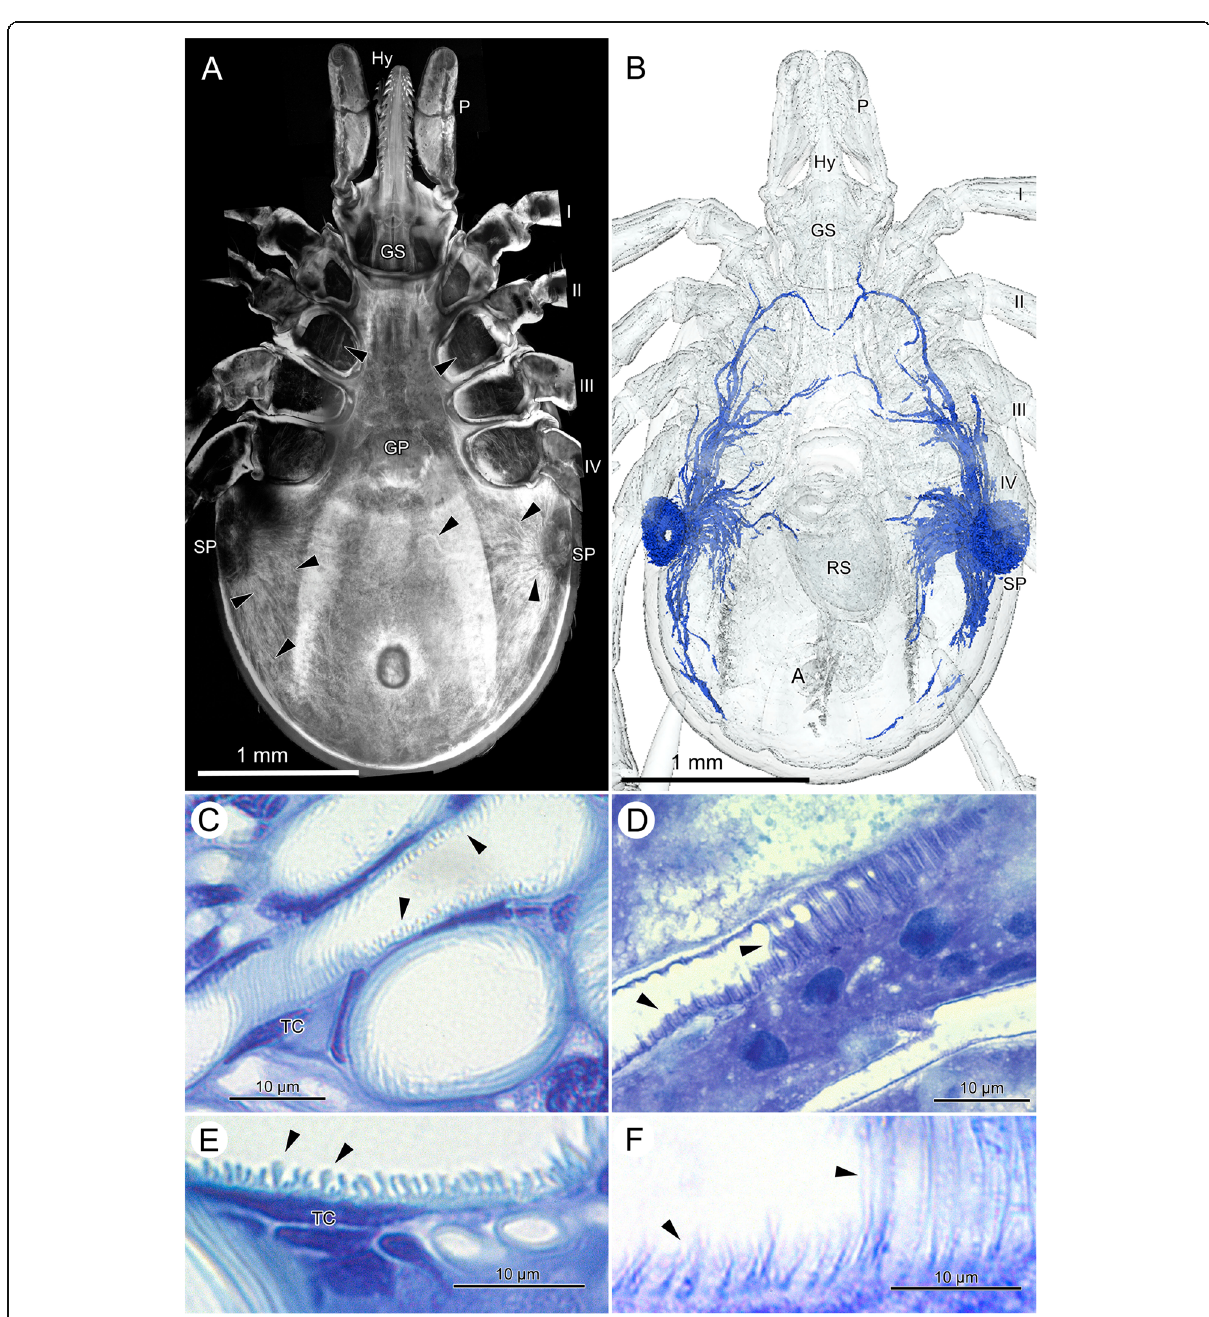
Fig. 6 Ixodes ricinus, cross morphology and histology of the tracheal system. a Autofluorescent CLSM image of the tracheal system, macerated specimen; ventral view; arrowheads indicate tracheae. b 3D-reconstruction of the major tracheal trunks based on μ CT-image stacks; ventral view. Tracheae are modeled in blue. The spatial resolution of the μ CT-images is about 15 μ m to recognize individual tracheae, therefore only tracheae larger than 15 μ m are shown. c LM micrograph with longitudinal and cross-sectional sections of tracheae from a fasting animal; arrow-heads indicate taenidia. d LM micrograph with longitudinal sections of tracheae from a fully engorged animal. Note that the taenidia are almost completely flattened as compared to ( c ); the un-stretchable core of exocuticle in the taenidia can be recognized as a straight lightly stained line; arrowheads indicate taenidia. e High-power LM micrograph of the tracheal wall, showing the taenidia in an unfed tick. f High-power LM micrograph of the tracheal wall, showing the taenidia in a fully engorged tick. Abbreviations: A, anus; GP, genital plate; GS, gnathosoma; Hy, hypostome; P, pedipalp; RS, receptaculum seminis; SP, spiracular plate; TC, tracheal cell; I – IV,